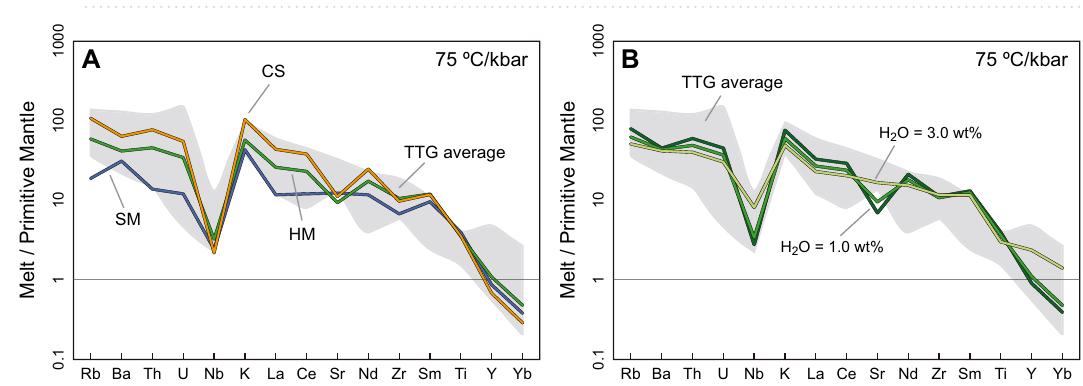
Figure 4. Bivariate plots for ( A ) Sr/Y vs La/Yb and ( B ) (La/Yb) N vs Yb N showing the geochemistry of calculated melts. Colored fields correspond to the regions defined by the high-, medium-, and low-pressure classification system for sodic TTGs and potassic granitoids from Moyen (2011). CS = Closed system, SM = Single melt fractions, HM = Hybrid melts. Different marker size schematically represents the volume of each melt fraction relative to the original equilibration volume.